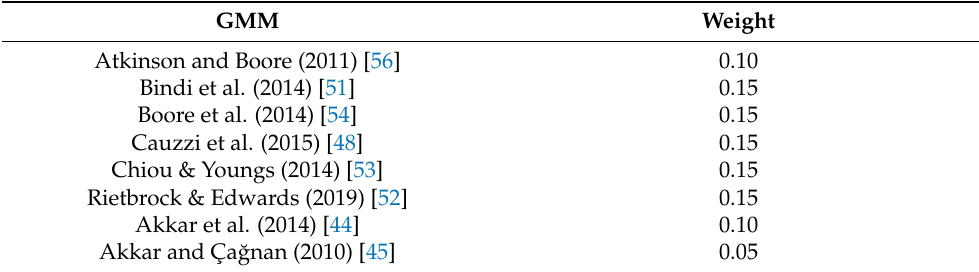
Table 6. Selected GMMs and their weights in the logic